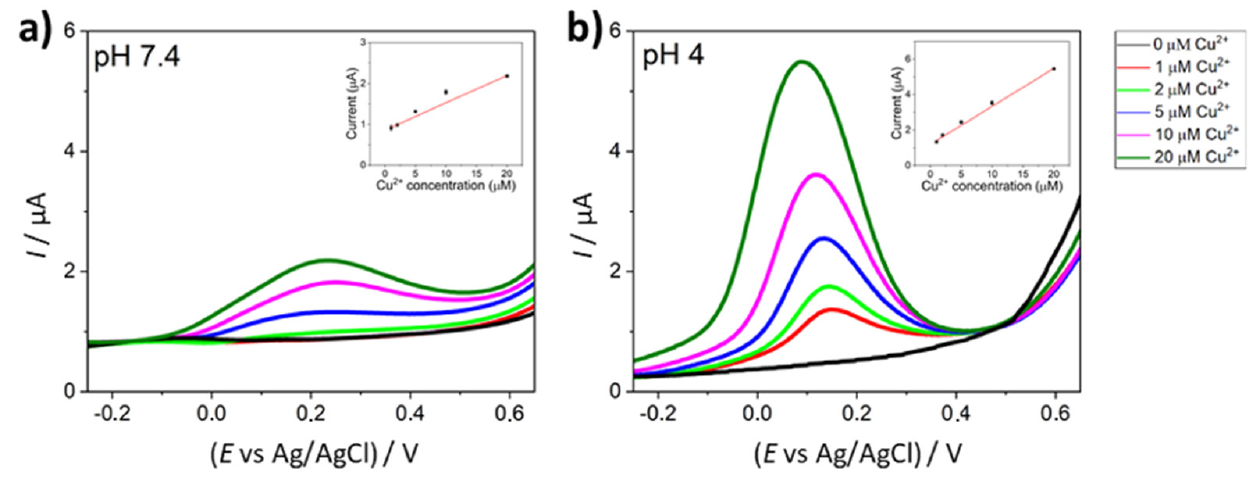
Figure 2. SWASV measurement for copper ions determination in ( a ) physiological condition (pH 7.4) and ( b ) acidic condition (pH 4). In the insets, we have the linear relation between ion concentration and the current intensity peak.